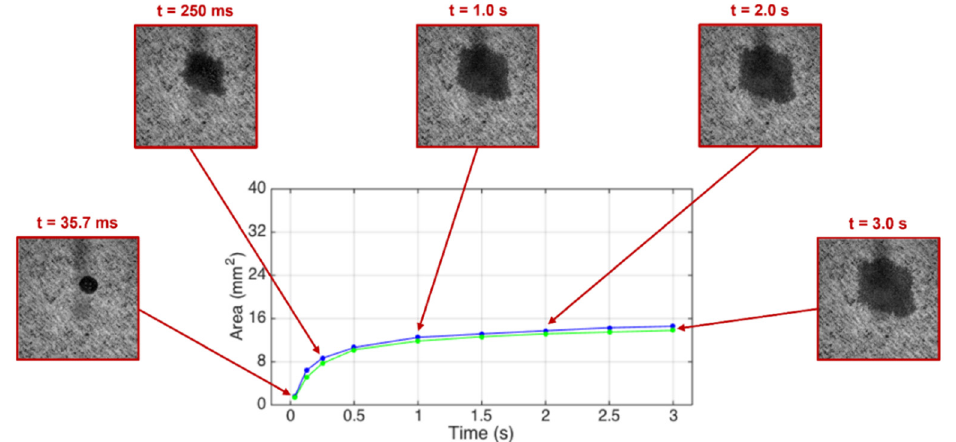
Figure 8. Water spreading area as a function of time for the non-compressed (blue line) and com- pressed (green line) base tissue paper sample B. The insets show the spreading area in different instants of time.